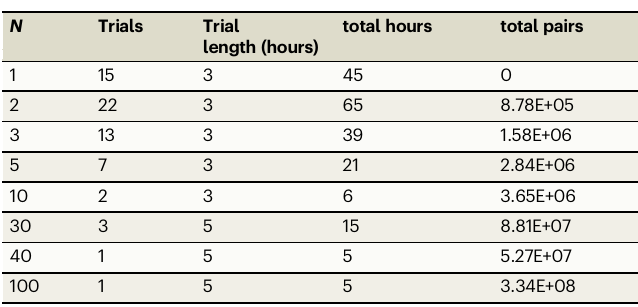
of blurring and thresholding the difference between the previous two panels to isolate the moving (magenta) and stationary (green) phases. These phases are overlayed onto the inverted raw